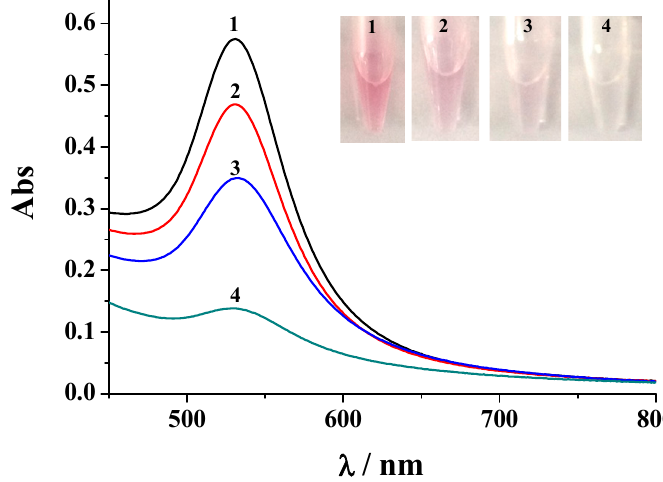
Figure 7. The UV-Vis absorption spectra and the photographic images (the inset) for assays of PSA in serum samples. Curves/tubes 1~4 correspond to the serum samples spiked with 0, 2, 4, and 8 ng/mL PSA, respectively. Table 2. Assays of PSA in serum samples.